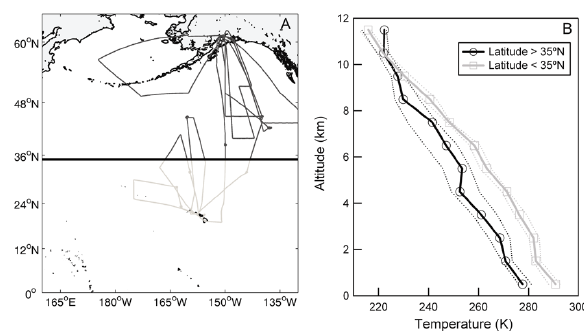
536 Fig. 1. (left panel) INTEX-B flight tracks made between 17 April Figure 1 : left panel INTEX-B flight tracks made between 17 April 2006 and 15 May 2006 over 537 2006 and 15 May 2006 over the Northern Pacific Ocean. Sampling the Northern Pacific Ocean. Sampling legs north of 35°N are shown in black, while legs south 538 of 35°N are shown in grey. right panel Observed mean temperature within 1 km altitude bins 539 legs north of 35 ◦ N are shown in black, while legs south of 35 ◦ N between 0-12 km divided into Northern (black) and Southern (grey) sampling bins. The dashed 540 are shown in grey. (right panel) Observed mean temperature within lines represent one standard deviation of the mean. 541 542 1km altitude bins between 0–12km divided into Northern (black) and Southern (grey) sampling bins. The dashed lines represent one standard deviation of the